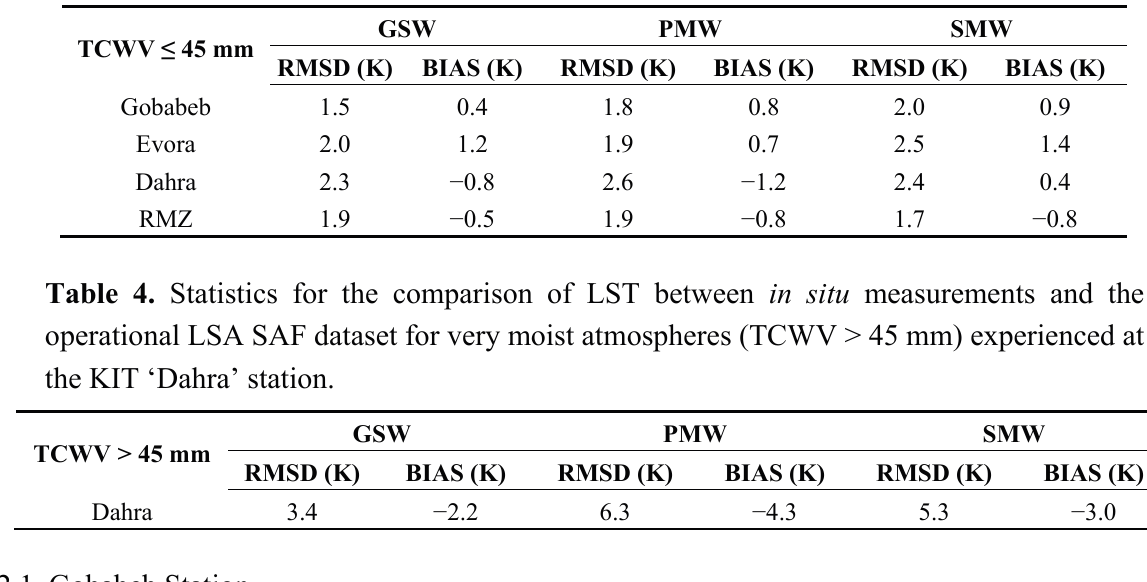
Table 3. Statistics for the comparison of LST between in situ measurements and the operational LSA SAF dataset for dry to medium-moist atmospheres (TCWV ≤ 45 mm).